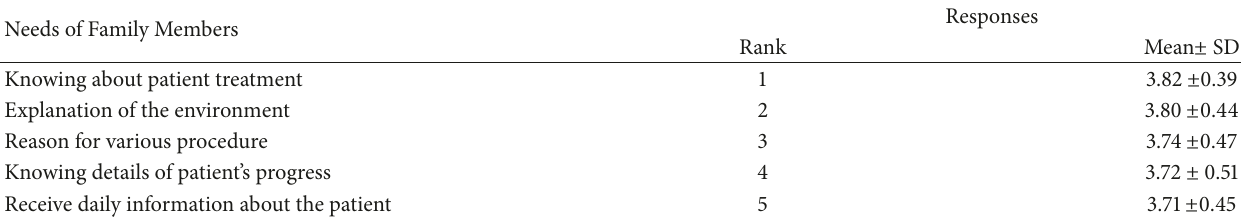
Table 3: Participants’ perception of five most important needs of family members.